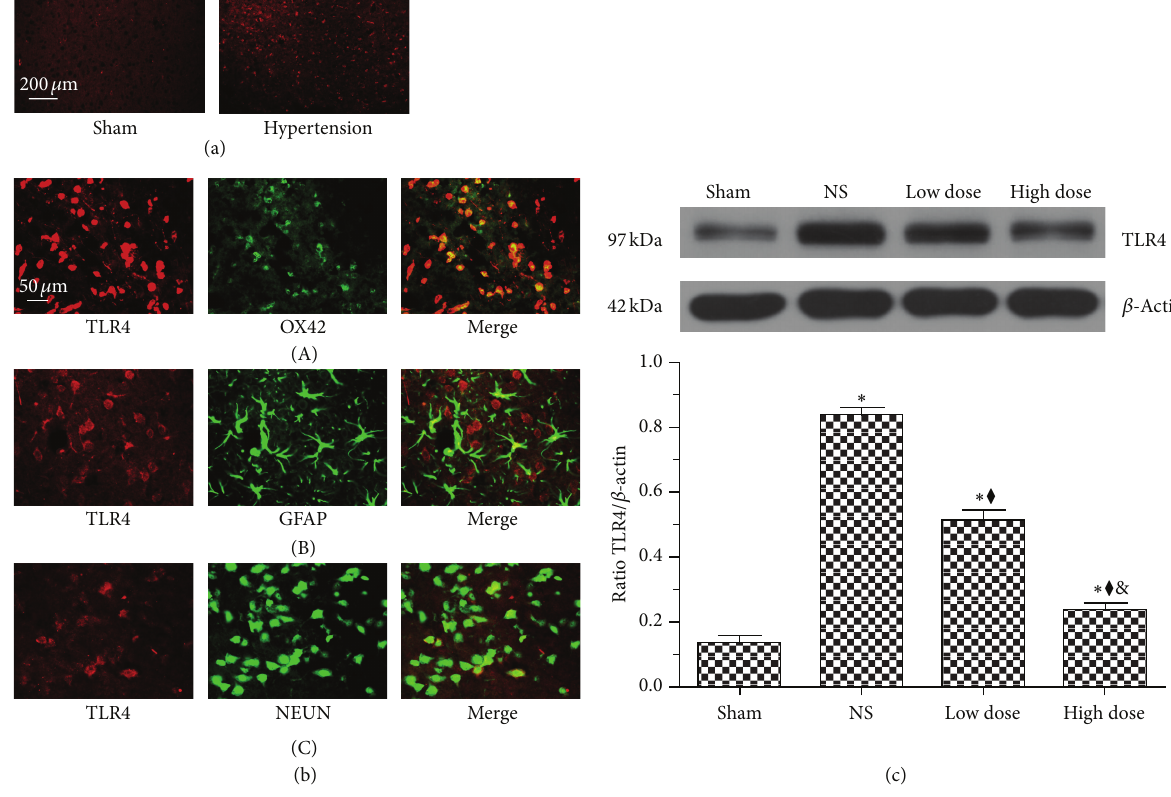
Figure 3: Scutellarin suppresses hypertension-induced expression of brain Toll-like receptor 4 (TLR4). (a) Chronic hypertension significantly enhanced the expression of TLR4 in the cerebral cortex. (b) Double immunofluorescence labeling indicated that the majority of TLR4 (red) was colabeled with OX-42-positive (green) cells and fewer with glial fibrillary acid protein- or Neuronal Nuclei-positive cells. (c) Western immunoblot analysis of brains of hypertensive rats showed that scutellarin dose-dependently suppressed the expression of TLR4. ∗ 𝑃 < 0.001 versus sham group; ⧫ 𝑃 < 0.001 versus NS group; & 𝑃 < 0.001 versus low-dose group. (c) Scale bar = 200 𝜇 m (a) and 50 𝜇 m